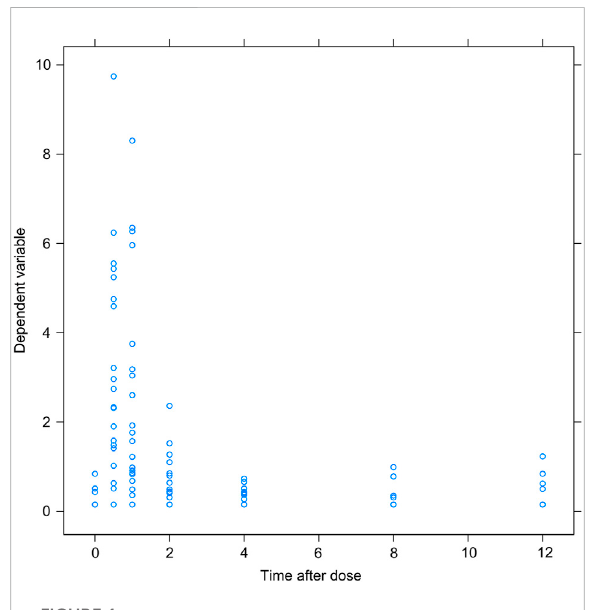
FIGURE 1 Scatter plot of MPA Observations vs. Time after last